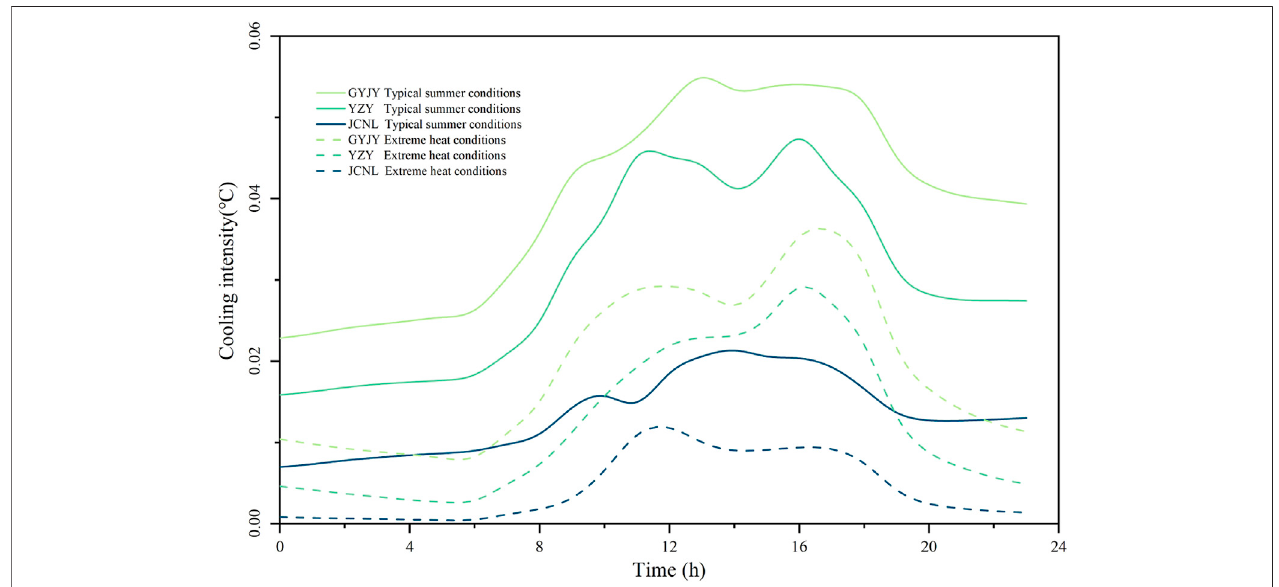
FIGURE4| Relationshipbetweenpedestrian-levelcoolingintensityandtheroofheight(orbuildingheight).Apolynomialfunction fi ttedtherelationships.Pointswith different shapes represent the pedestrian-level cooling intensity at different times, and the color of the lines represents two weather conditions.